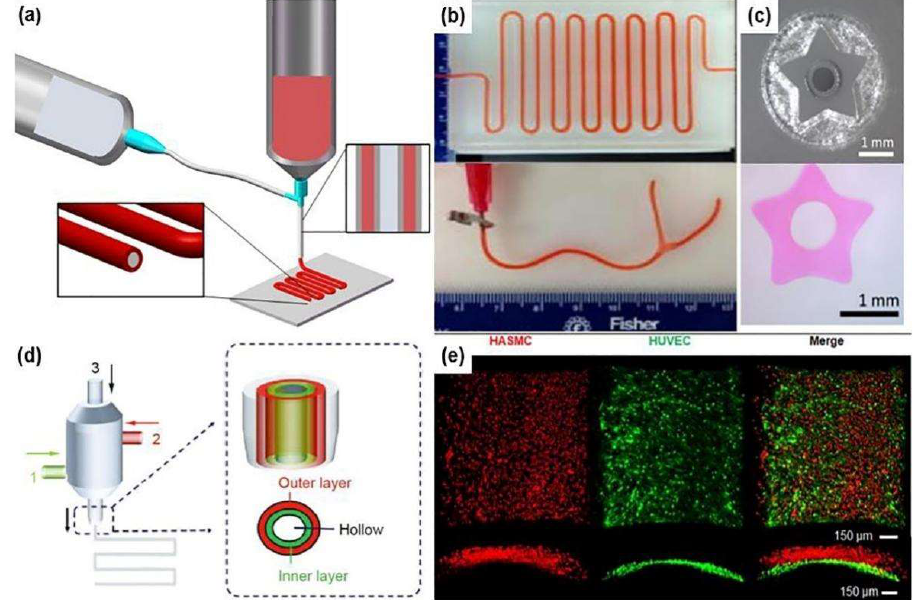
Figure 6. ( a ) Schematic illustration of a coaxial bioprinting technique. ( b ) A long vasculature conduit printed in a zigzag pattern with perfused cell culture media, and a branched vasculature, reported by Zhang et al. Reprinted from Ref. [67]. ( c ) A customized nozzle with a 5-point star geometry and the cross-section of the 5-point star tube produced using the nozzle, reported by Millik et al. Reprinted from Ref. [68]. ( d ) Schematic illustration of a multichannel coaxial extrusion system, reported by Pi et al. Two cellular bioinks are delivered respectively through the openings 1, 2 to form the second (i.e. middle) and third (i.e. outer) layers of the vessels, while a sacrificial material is delivered through the opening 3 to form the inner layer of the vessel. Reprinted from Ref. [70]. ( e ) A double-layered blood-vessel-like structure produced using a triple concentric nozzle, in which, human smooth muscle cells (hSMCs) in red and human umbilical vein endothelial cells (HUVECs) in green at day 5, reported by Bosch et al. Reprinted from Ref. [72]. In 2020, Liang et al. prepared a novel hydrogel with high-strength by inserting N-acryloylglycinamide (NAGA) monomer with intramolecular multiple hydrogen bonds into the macromolecular chain of methacrylated gelatin (GelMA) hydrogel. Through in- troducing NAGA monomers and nanoclay (Clay) into the GelMA hydrogel, a small-diameter vascular stent was produced using the coaxial bioprinting technique [69]. A high-performance vascular stent with a tensile strength of 22 MPa, a stretchability of 500%, a Young’s modulus of 21 MPa, an anti-fatigue performance of 200 cycles, and a